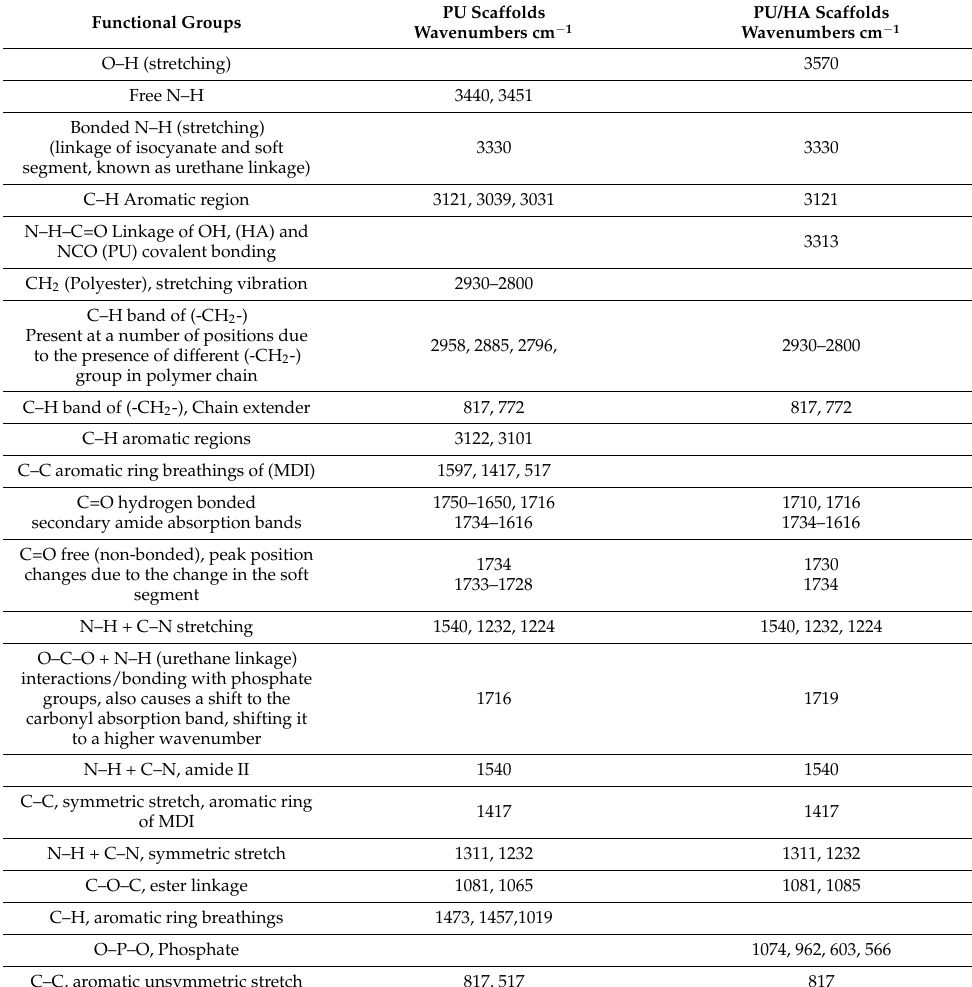
Figure 4. FTIR (PAS) spectrum overlap PU and PU/HA scaffolds related with main peaks. Table 1. The bands of PU and PU/HA scaffolds using FTIR [19,30,31].